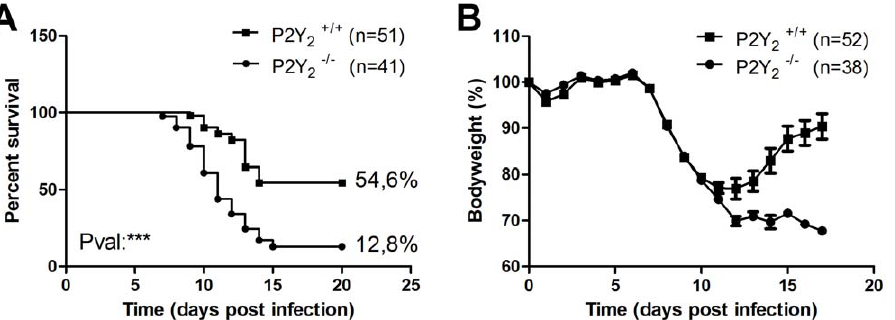
Figure 1. Higher mortality rate in PVM-infected P2Y 2 -deficient mice. Following intranasal inoculation of PVM (1000 PFUs), P2Y 2 + / + and P2Y 2 2 / 2 mice were monitored daily for survival ( A ) and weight loss ( B ). Weight curves (mean 6 SEM) are relative to initial body weight. The displayed data result from the pooling of four independent experiments.